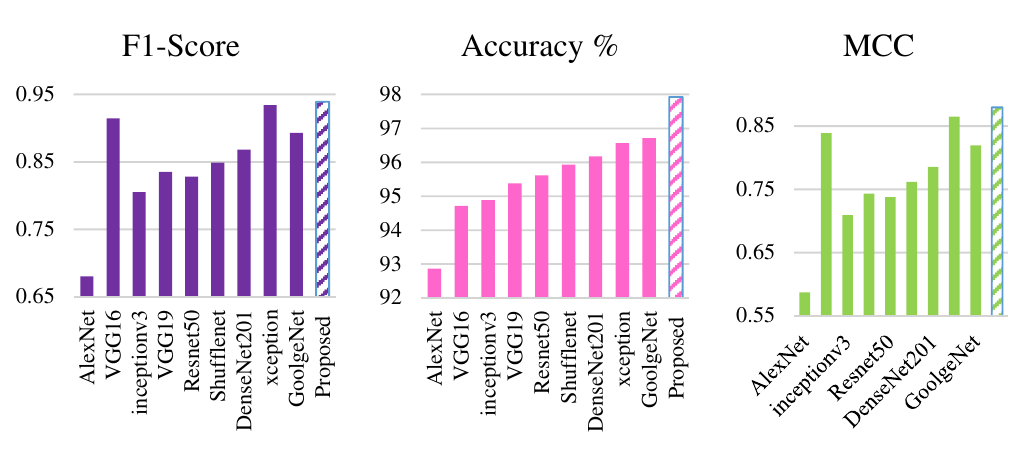
Figure 7. F1-score, accuracy, and MCC